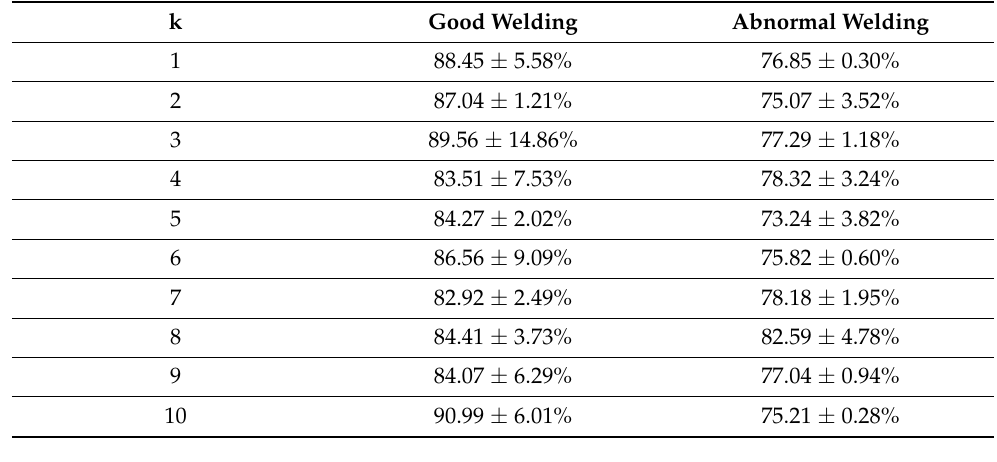
Table 1. Performance of the fully connected deep neural network.